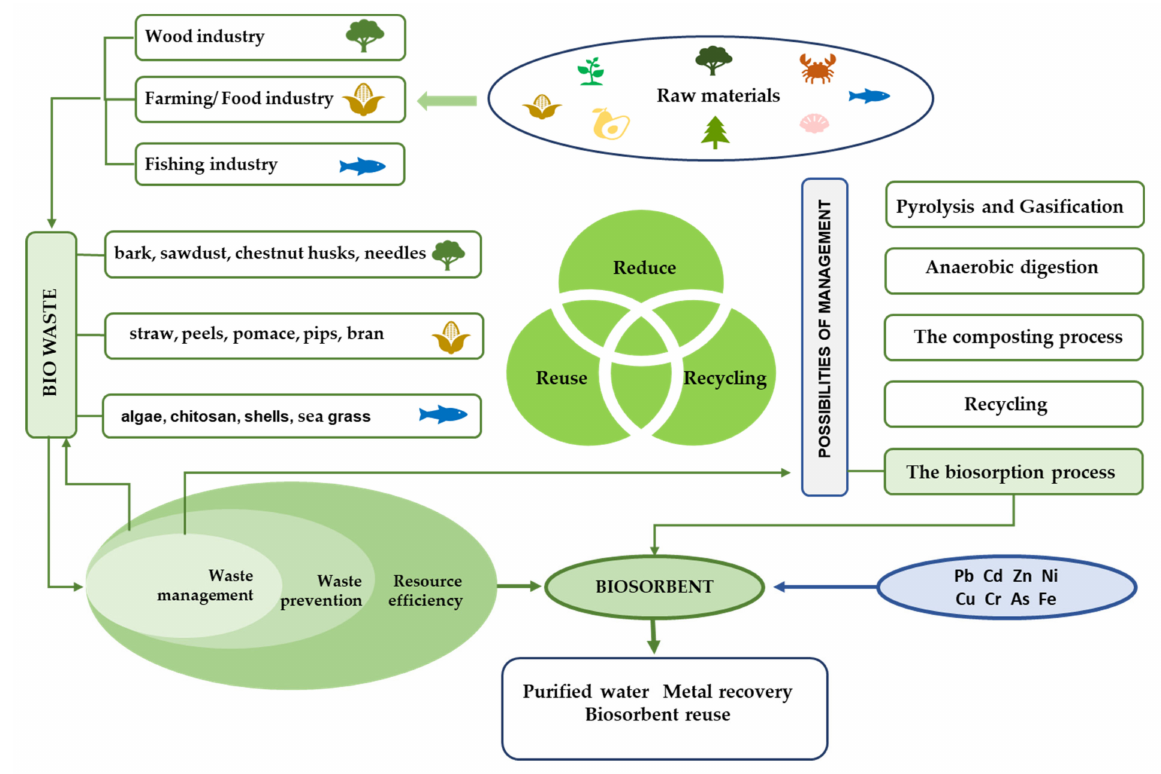
Figure 1. Concept of managing biowaste towards a circular economy, based on